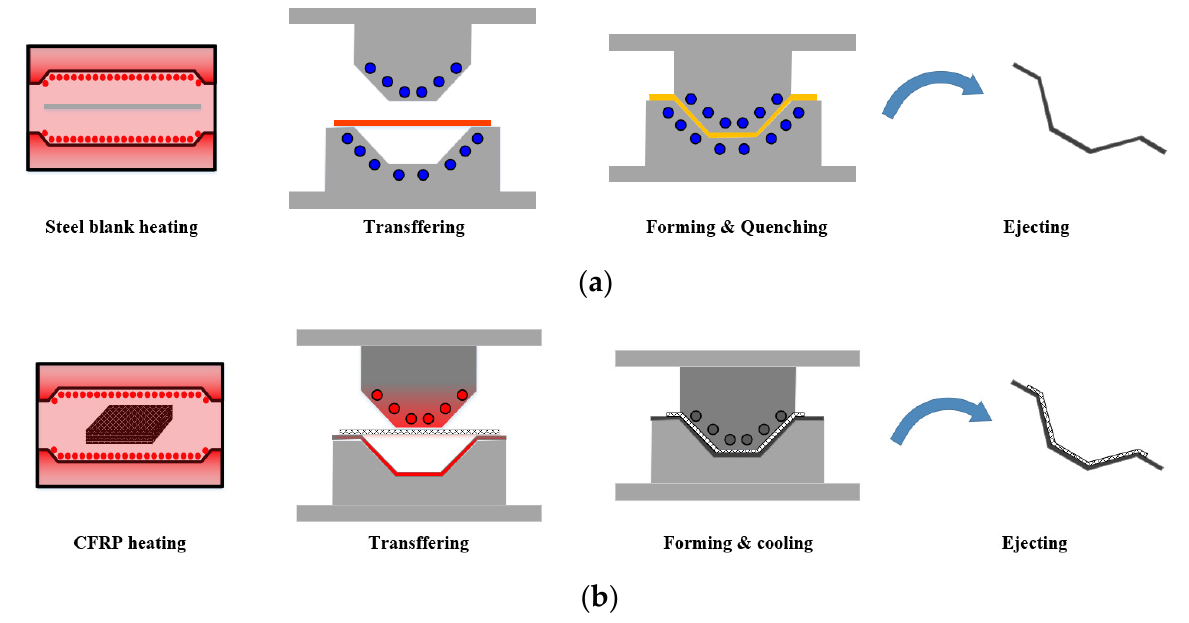
Figure 1. Schematic diagram for the manufacturing of the B-pillar assembly. ( a ) Hot stamping process for the manufacturing of the B-pillar using boron steel. ( b ) PCM process for the manufacturing of the reinforcement using CFRP.